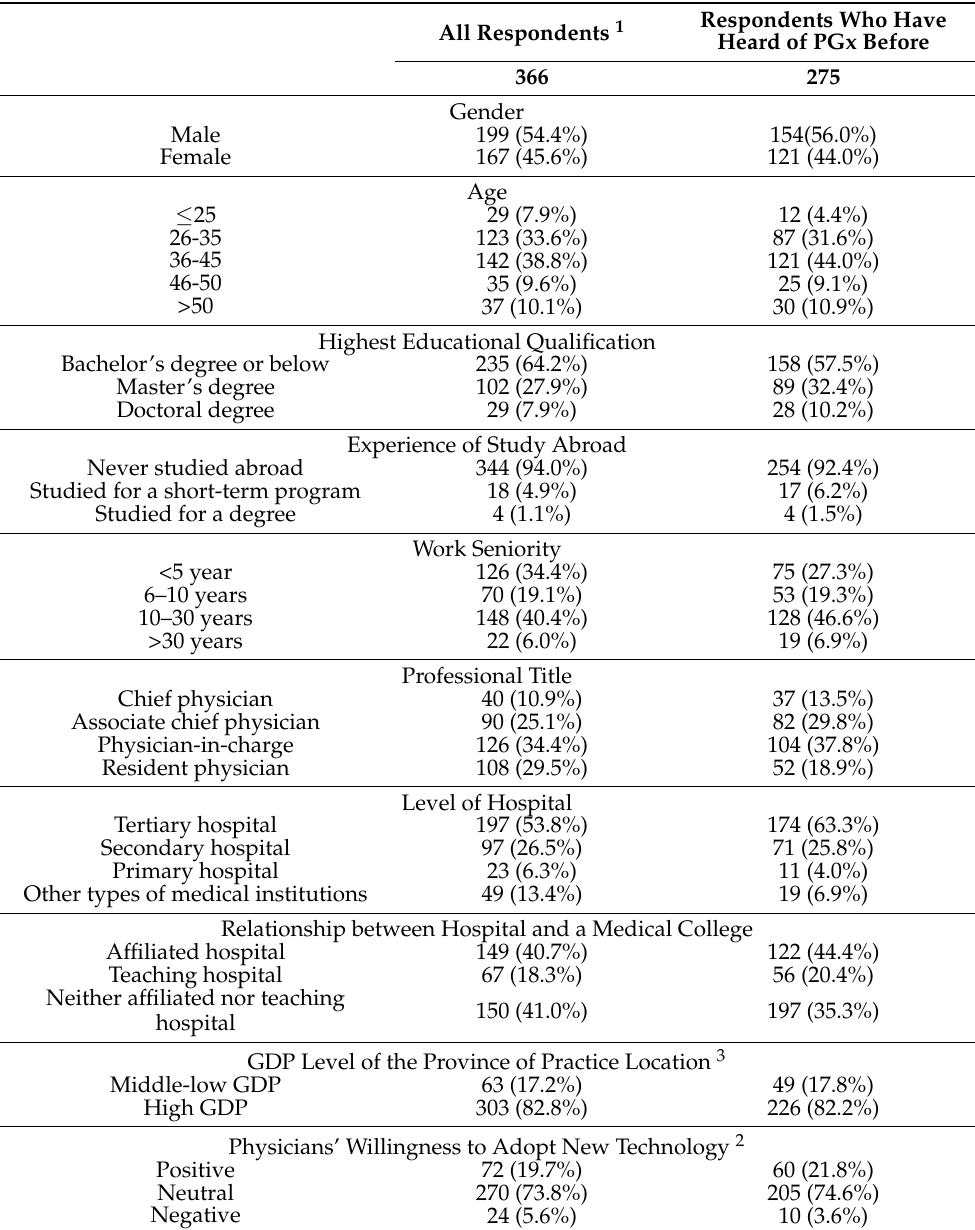
Table 1. Characteristics of respondents in our